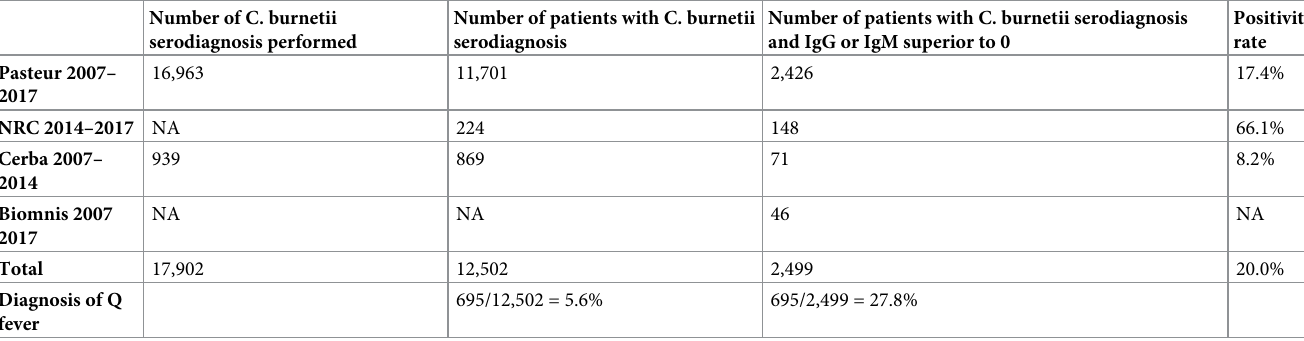
Table 3. Rate of positivity according to the lab. Number of C. burnetii serodiagnosis performed